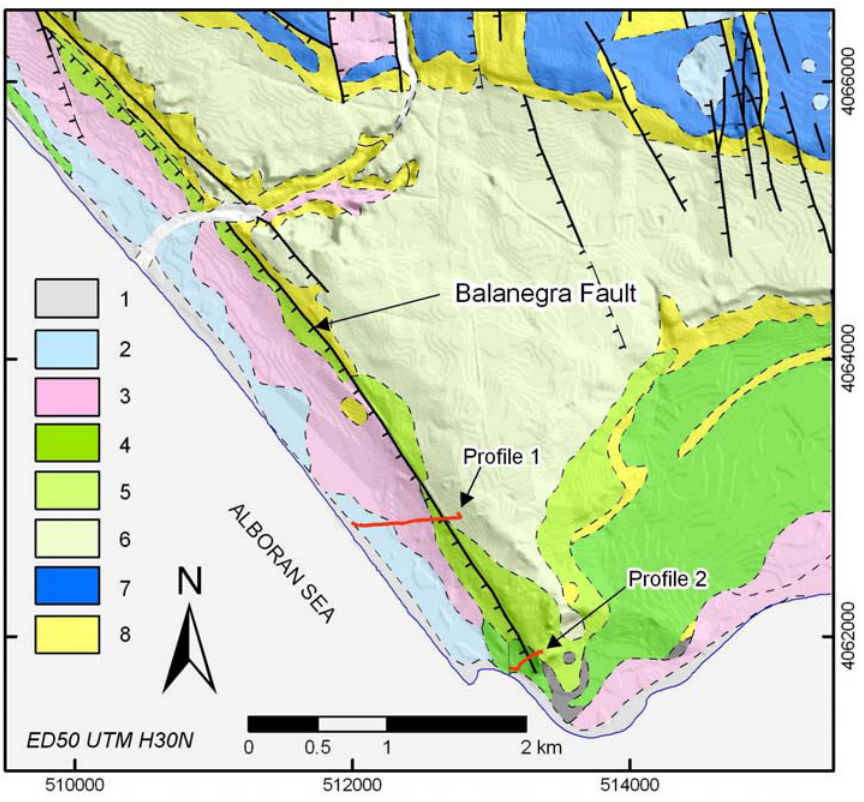
Figure 3. Detailed geological map of the southern end of Balanegra Faults including levelling profile location. 1: beach deposits (Holocene), 2: fluvial deposits (Holocene), 3: dunes (Holocene), 4: marine terrace (late Pleistocene), 5: marine terrace (middle Pleistocene), 6: marine terrace (early Pleistocene), 7: distal alluvial fans (Quaternary), 8: sands and silts (Pliocene).